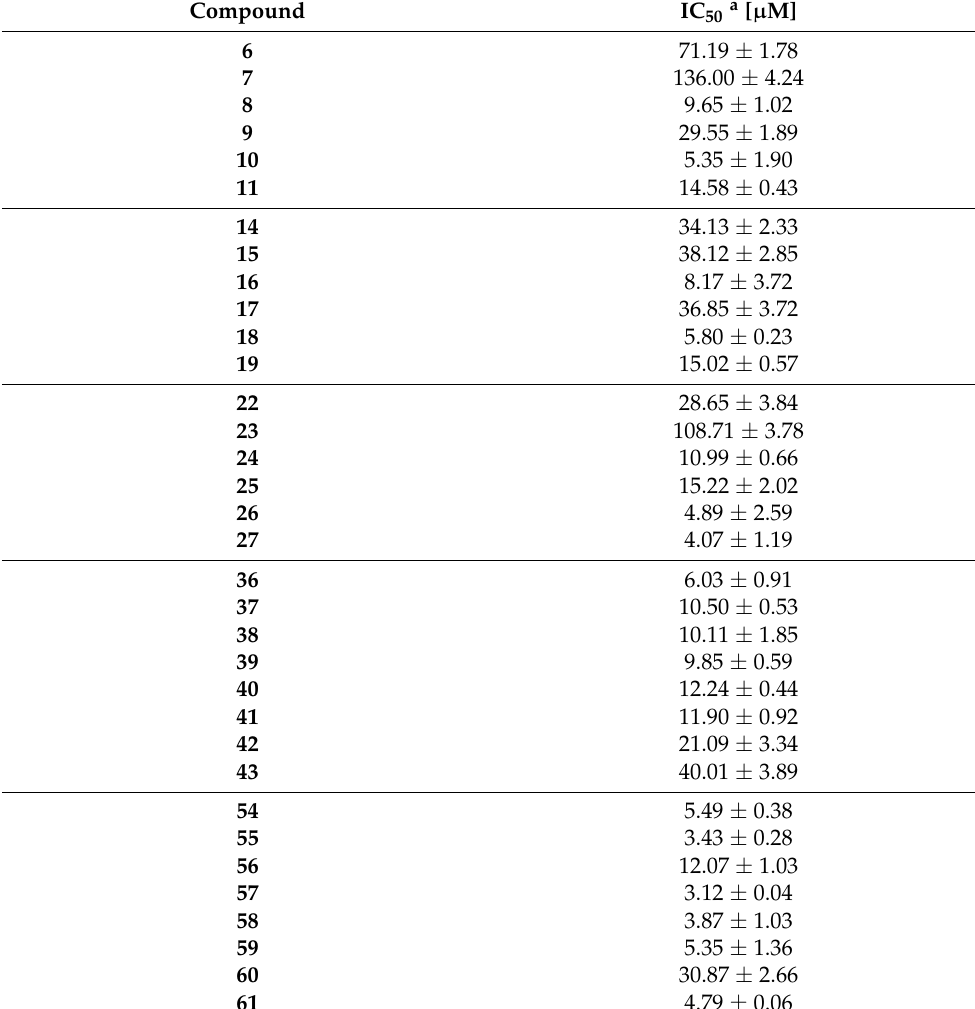
Table 2. Cellular cytotoxic activity of compounds 6 – 11 , 14 – 19 , 22 – 27 , 36 – 42 , and 54 – 61